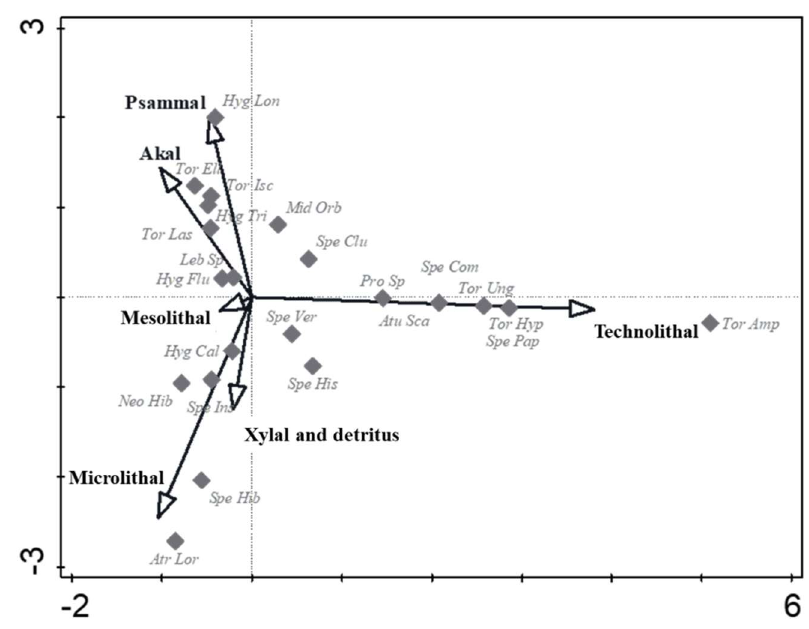
Figure 3. Canonical correspondence analysis (CCA) ordination of microhabitat structure and water mite variability in a lowland river. Individual water mite species are marked by grey diamonds ( ♦ ). Only adult water mite specimens (identified at the species or genus level for Lebertia sp. and Protzia sp.) were considered in this analysis. Available microhabitats are indicated by arrows. The arrow lengths on the ordination show the relative importance of the explanatory variables. The eigenvalues of the first two axes were 0.610 and 0.543, respectively. A Monte Carlo permutation test indicated that ordination was statistically significant (F = 2.4, p = 0.01). Atractides loricatus = Atr Lor, Aturus scaber = Atu Sca, Hygrobates calliger = Hyg Cal, H. fluviatilis = Hyg Flu, H. longiporus = Hyg Lon, H. trigonicus = Hyg Tri, Lebertia sp . = Leb Sp, Mideopsis orbicularis = Mid Orb, Neoacarus hibernicus = Neo Hib, Protzia sp. = Pro Sp, Sperchon clupeifer = Spe Clu, S. compactilis = Spe Com, S. hibernicus = Spe Hib,